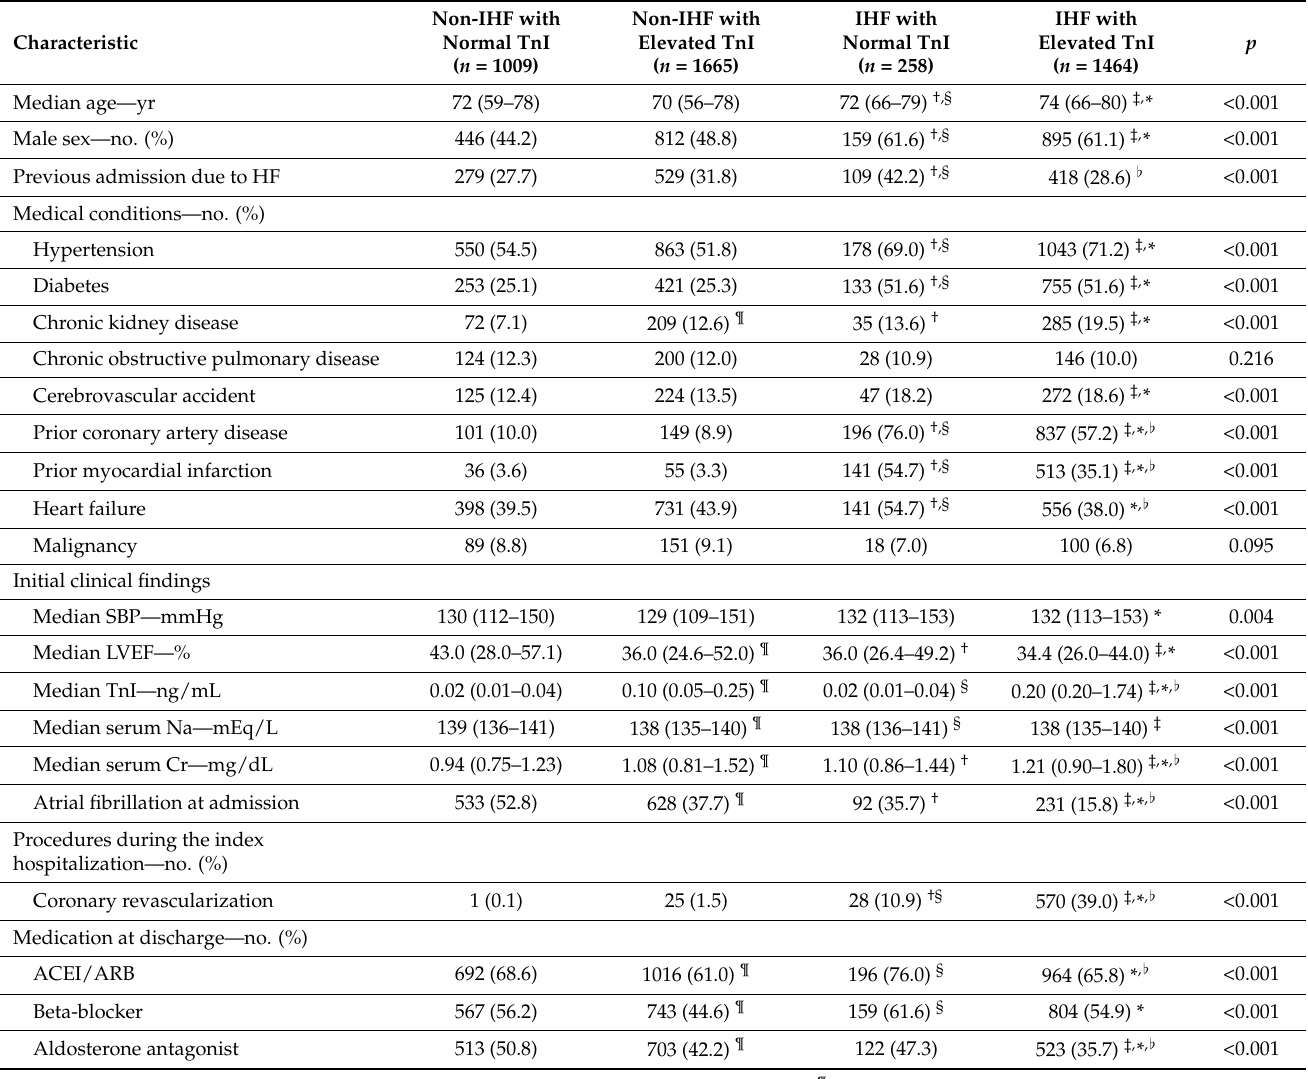
Table 1. Baseline characteristics of patients in the four